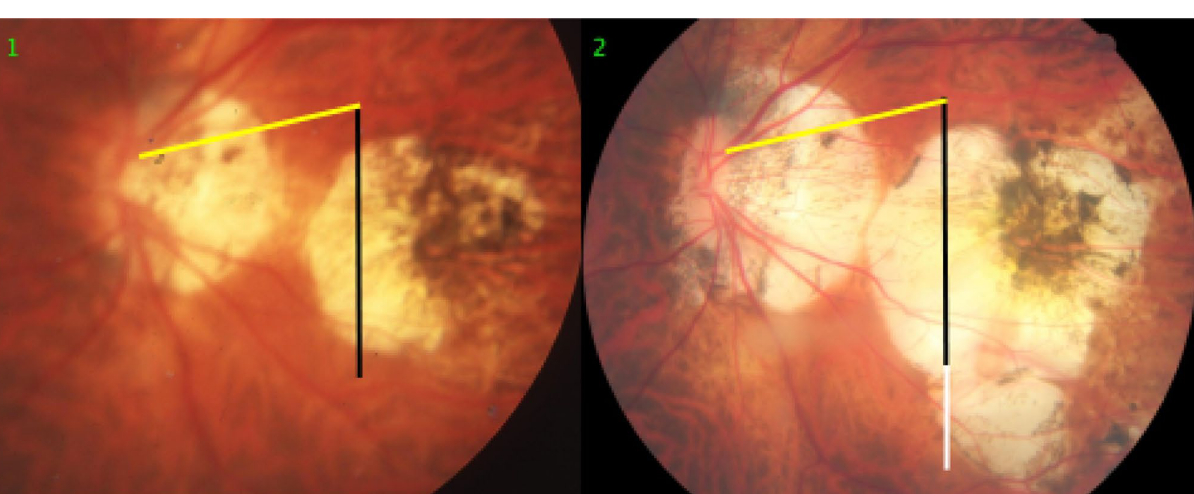
Figure 5. Fundus photographs of a highly myopic eye taken with an interval of 10 years (left image taken in 2001; right image taken in 2011). Note : enlargement of the foveal Bruch´s membrane defect (category 4 of myopic macular degeneration) without underlying large choroidal vessels). Elongation of the distance between two vertical choroidal vascular markings, compared between baseline (vertical black bar) and follow up (equally long vertical black bar plus white bar), suggesting a spreading of the choroidal vessels and corresponding in size to the vertical enlargement of the Bruch’s membrane defect. Distance between the choroidal marking and the disc border (equally long yellow bars) constant during